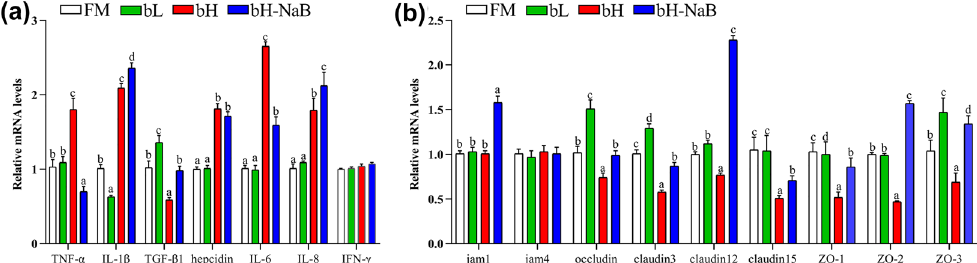
Figure 5. Distal intestinal inflammation- and tight junctions-related genes expression in juvenile hybrid groupers ( Epinephelus fuscoguttatus ♀ × E. lanceolatus ♂ ) fed the experimental diets for 8 weeks. Results are represented as the means ± SE (n = 8). Significance was evaluated by one-way ANOVA followed by Tukey multiple range tests. FM control diet, bL containing 1.5% 7S diet, bH containing 6% 7S diet, bH-NaB containing 6% 7S and 0.13% NaB diet. a,b,c,d Mean values denoted by different superscripted letters differ significantly at